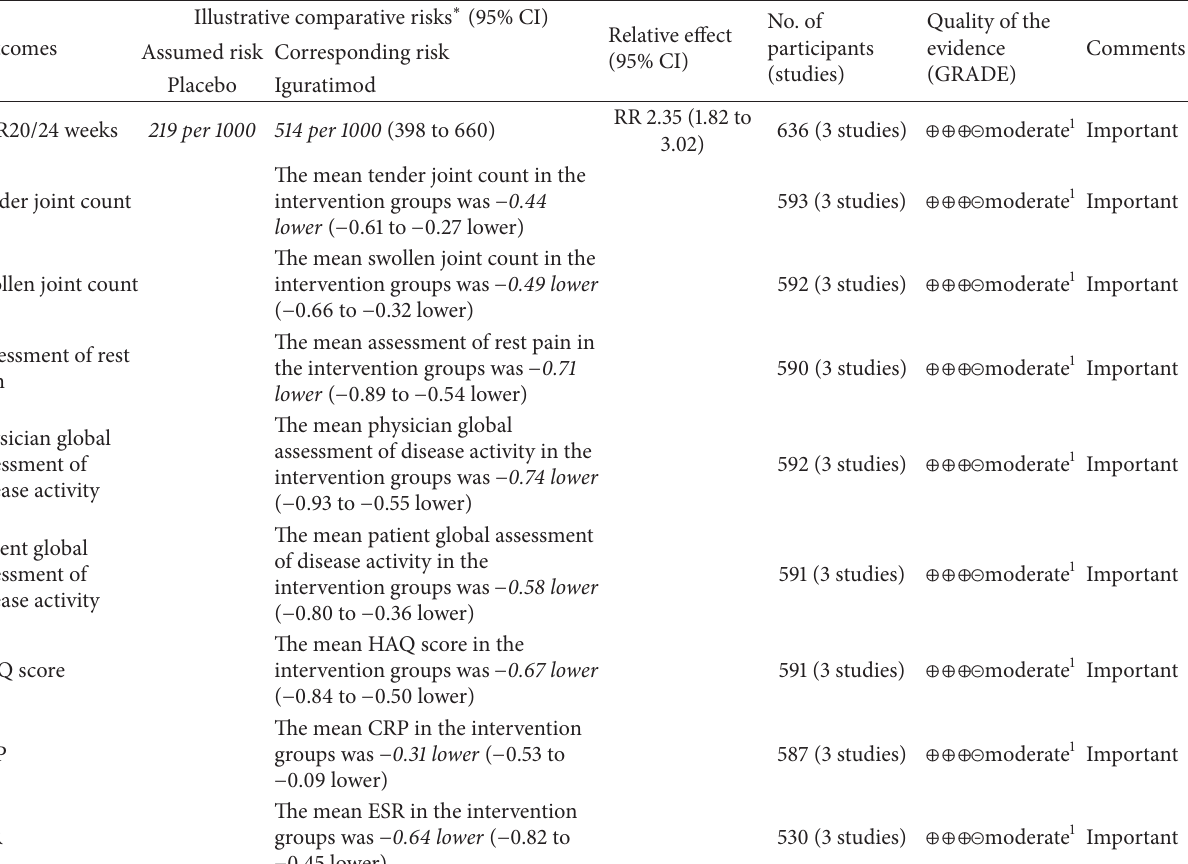
Table 2: Summary of the findings for the main comparison: iguratimod compared to placebo for rheumatoid arthritis.